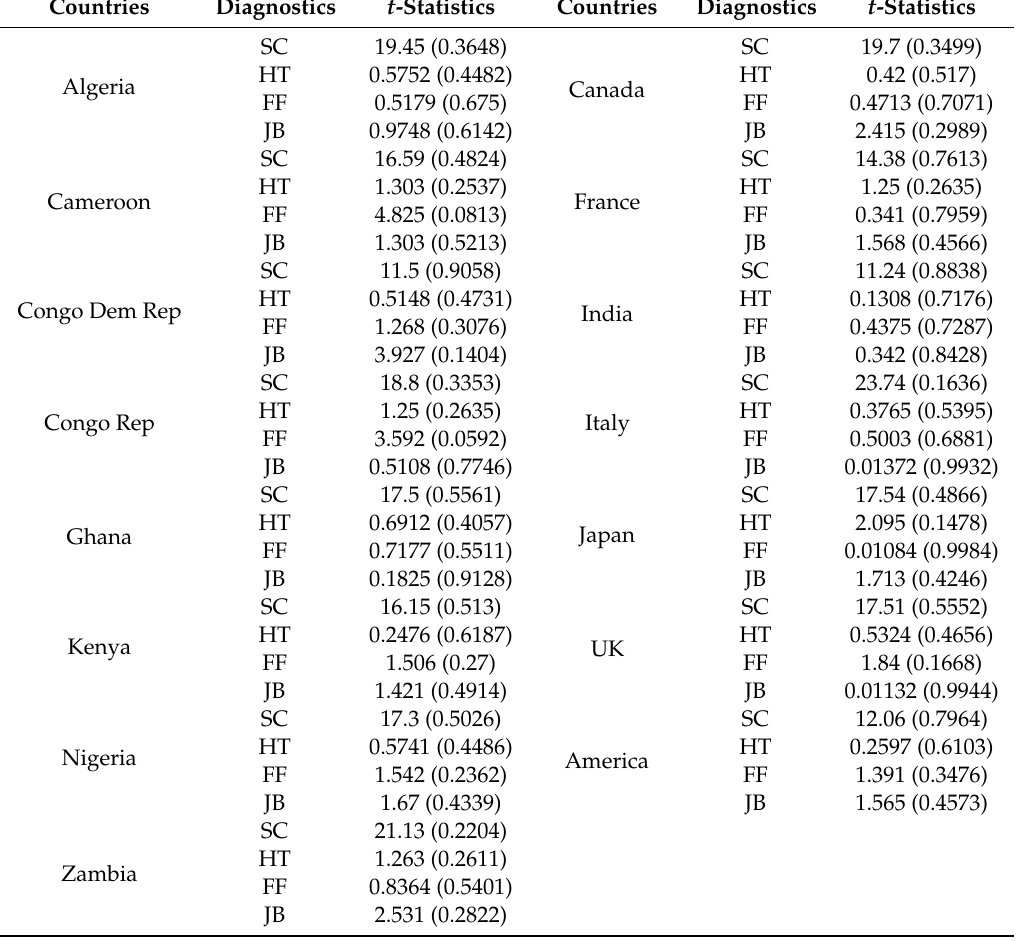
Table 8. Diagnostic checking